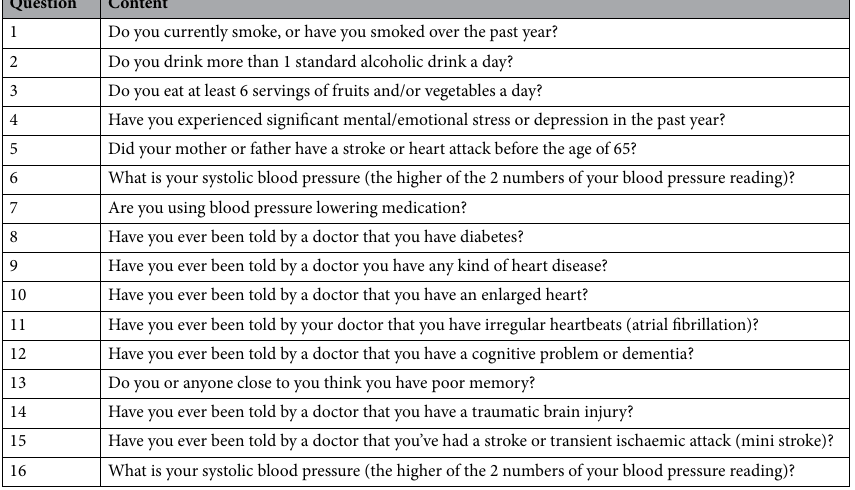
Generally, for the two-facet design, expressed as P × I × C, the effects for all facets were presented by X which was the observed score of a person on a particular item across countries and were obtained as below 15,24 :